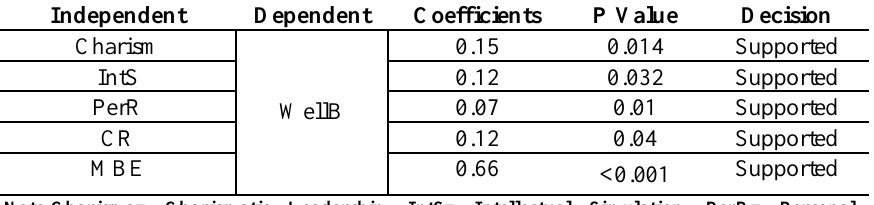
Table.5. Path Coefficients When Employee Well-being is Dependent Independent Dependent Coefficients P Value